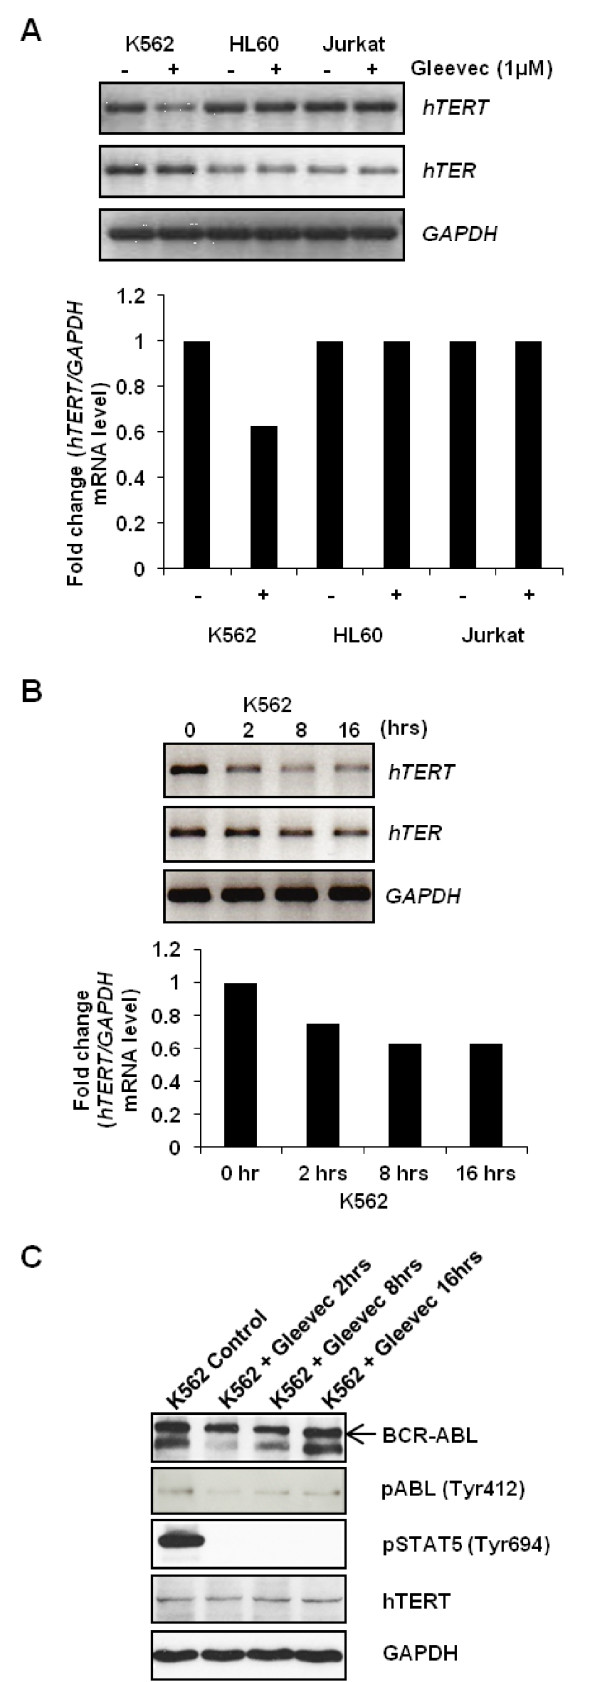
Gleevec reduces hTERT mRNA level in K562 cells. (a) 1 μM Gleevec treatment for 16 h inhibits hTERT mRNA level in K562 but not in HL60 and Jurkat cells. Upper Panel: RT-PCR image; Lower Panel: Quantitation of the RT-PCR image. (b) hTERT mRNA level in K562 cells was gradually reduced with increased incubation time upon 1 μM Gleevec treatment. Upper Panel: RT-PCR image; Lower Panel: Quantitation of the RT-PCR image. (c) Endogenous proteins expression level of K562 cells under 1 μM Gleevec treatment for 2, 8 and 16 h